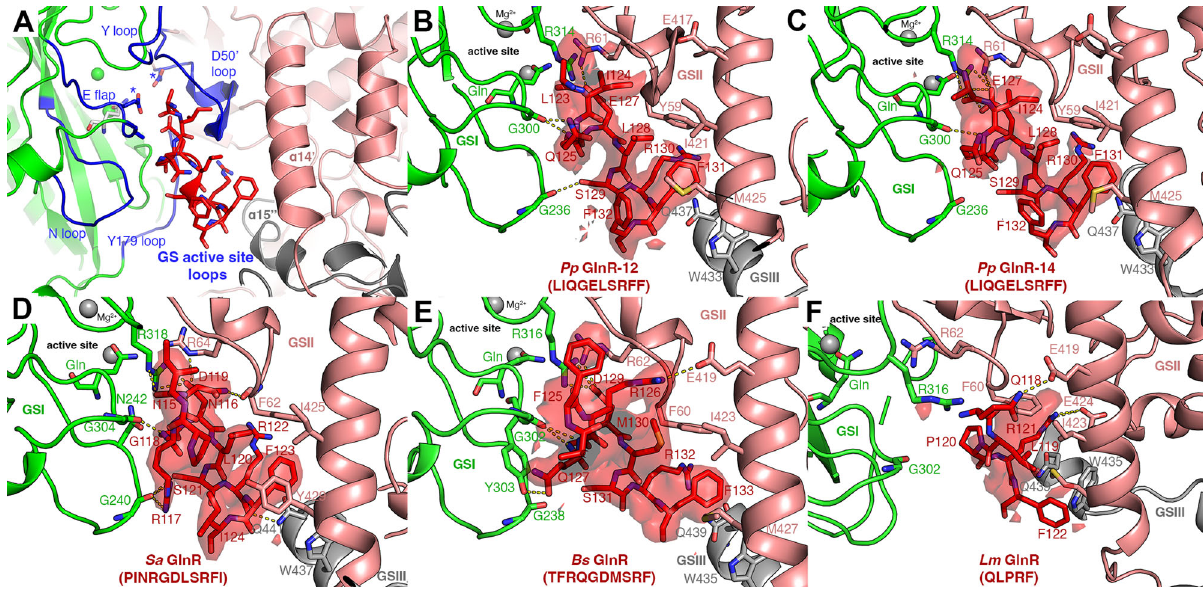
Fig. 4 Cryo-EM FBI-GS-GlnR structures reveal GlnR binds in the GS active site. A Cartoon diagram of the Pp GlnR C-tail (red) binding to GS. GlnR binds in the GS active site between two subunits and at the nexus of the oligomer interface between stacked rings. In this fi gure one GS subunit is colored green and the other salmon. The active site regions are colored blue and labeled. B Density for GlnR peptide and contacts with GS in the Pp FBI-GS(12)-GlnR complex (map contoured at 0.09 σ ). Residues making contacts are labeled and different GS subunits are denoted as GSI, GSII, and GSIII, underscoring that three GS subunits participate in GlnR contacts. C Density for GlnR peptide and contacts with GS in the Pp FBI-GS(14)-GlnR complex (map contoured at 0.06 σ ). D Density for GlnR peptide and contacts with GS in the Sa FBI-GS-GlnR complex (map contoured at 0.15 σ ). E Density for GlnR peptide and contacts with GS in the Bs FBI-GS-GlnR complex (map contoured at 0.65 σ ). F Density for GlnR peptide and contacts with GS in the Lm FBI-GS-GlnR complex (map contoured at 0.55 σ